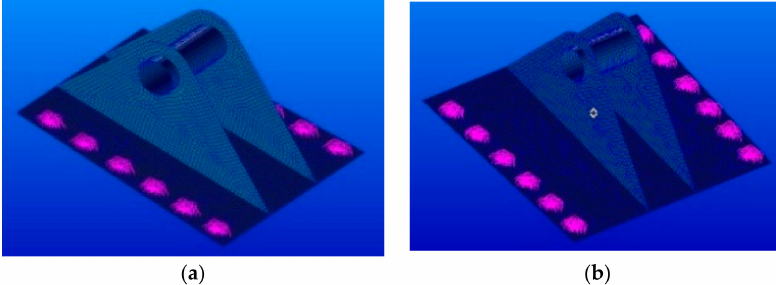
Figure 11. Sizing optimization FE model: ( a ) upper support; ( b ) lower